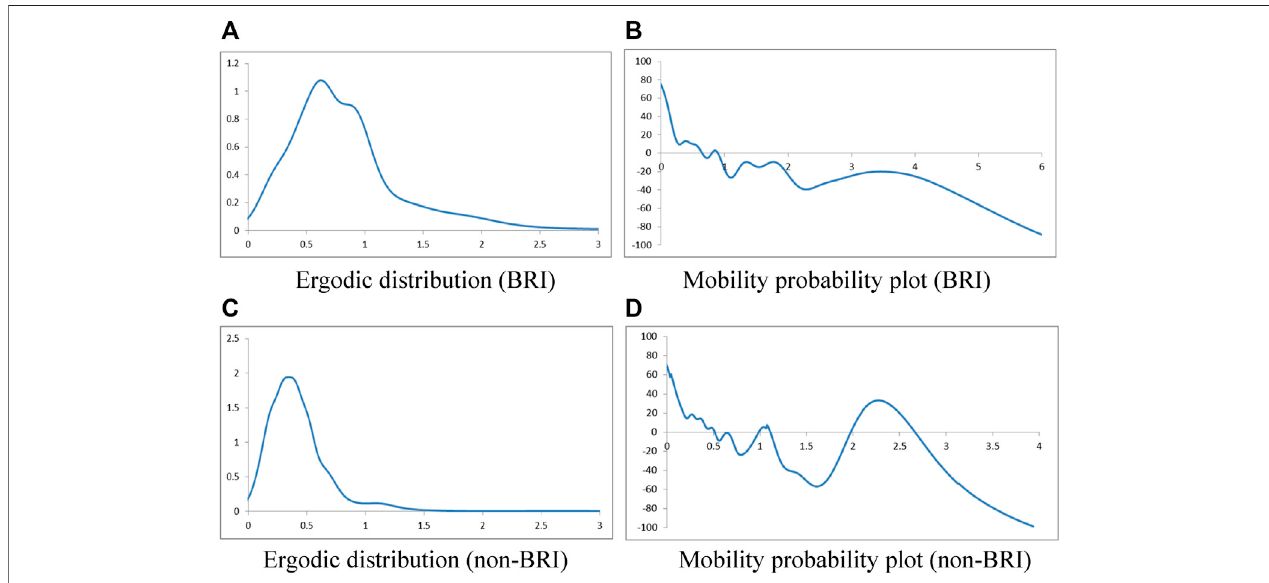
FIGURE6| ErgodicdistributionandMobilityprobabilityplotofcarbonemissionperPPP. (A) Ergodicdistribution(BRI) (B) Mobilityprobabilityplot(BRI). (C) Ergodic distribution (non-BRI) (D) Mobility probability plot (non-BRI).